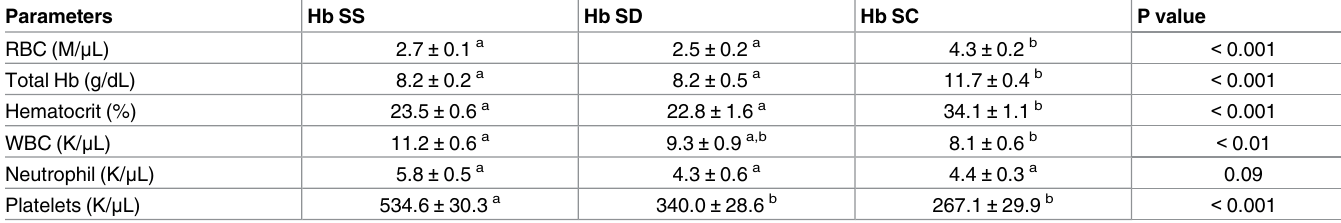
Table 2. Hematological profile of the SCD genotypes.